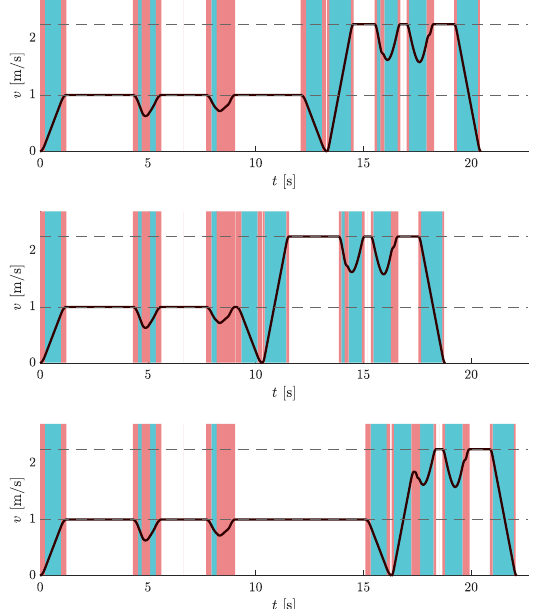
Figure 14. Velocity profiles of AGV traveling on a circular route for different placements of pick-up and drop-off points: A and A (cid:48) ( top ), A and B ( middle ), A and C ( bottom ). The graphs show the results for PUP → DOP: F F , and DOP → PUP: N N . Dashed horizontal lines represent the velocity limit values. Blue vertical bands indicate intervals where the acceleration reaches its maximum allowable values. Similarly, red vertical bands indicate intervals when the jerk reaches its maximum allowable